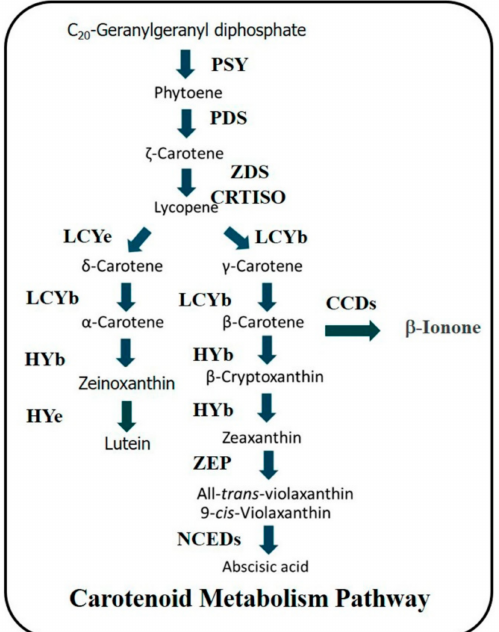
Figure 1. The principal pathway of carotenoid metabolism in higher plants. Abbreviations of carotenoid metabolic enzymes: PSY, phytoene synthase; PDS, phytoene desaturase; ZDS, ζ -carotene desaturase; CRISO, carotenoid isomerase; LCYe, lycopene ε -cyclase; LCYb, lycopene β -cyclase; HYe, ε -ring hydroxylase; HYb, β -ring hydroxylase; ZEP, zeaxanthin epoxidase; CCDs, carotenoid cleavage dioxygenases; NCEDs, 9- cis -epoxycarotenoid